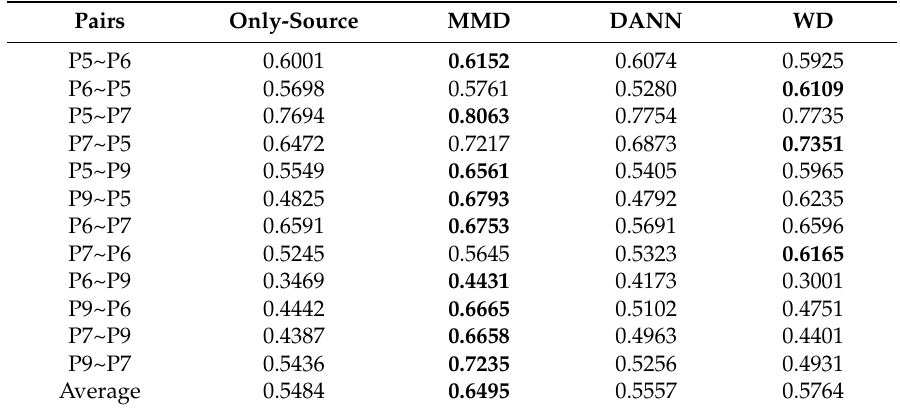
Table 7. The second round of experiment results of USC. In this round of experiments, Target only used 20% of the unlabeled data to participate in the training, using the remaining 80% for testing. The bold number is the best result for the experiments in the same row.